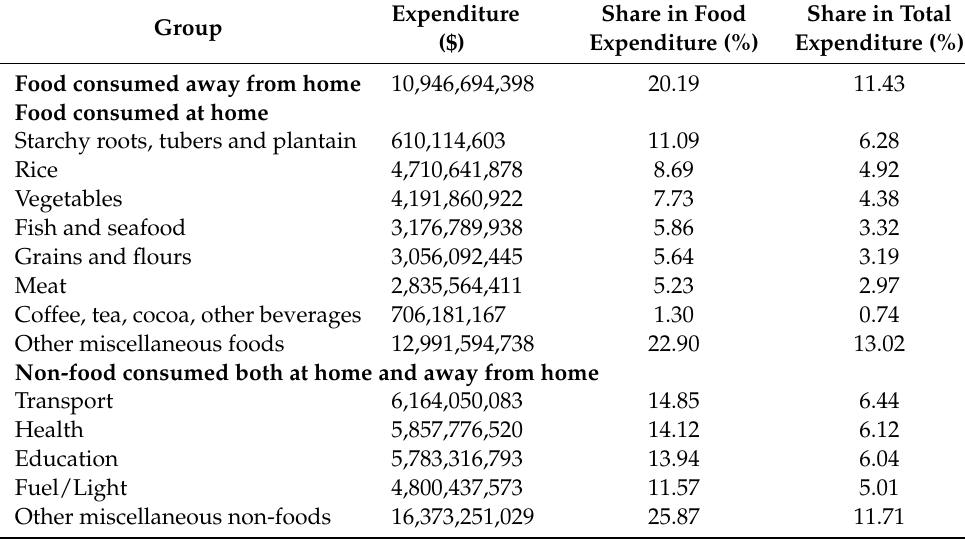
Table 1. Aggregate households in Nigeria expenditure by type of commodity: National